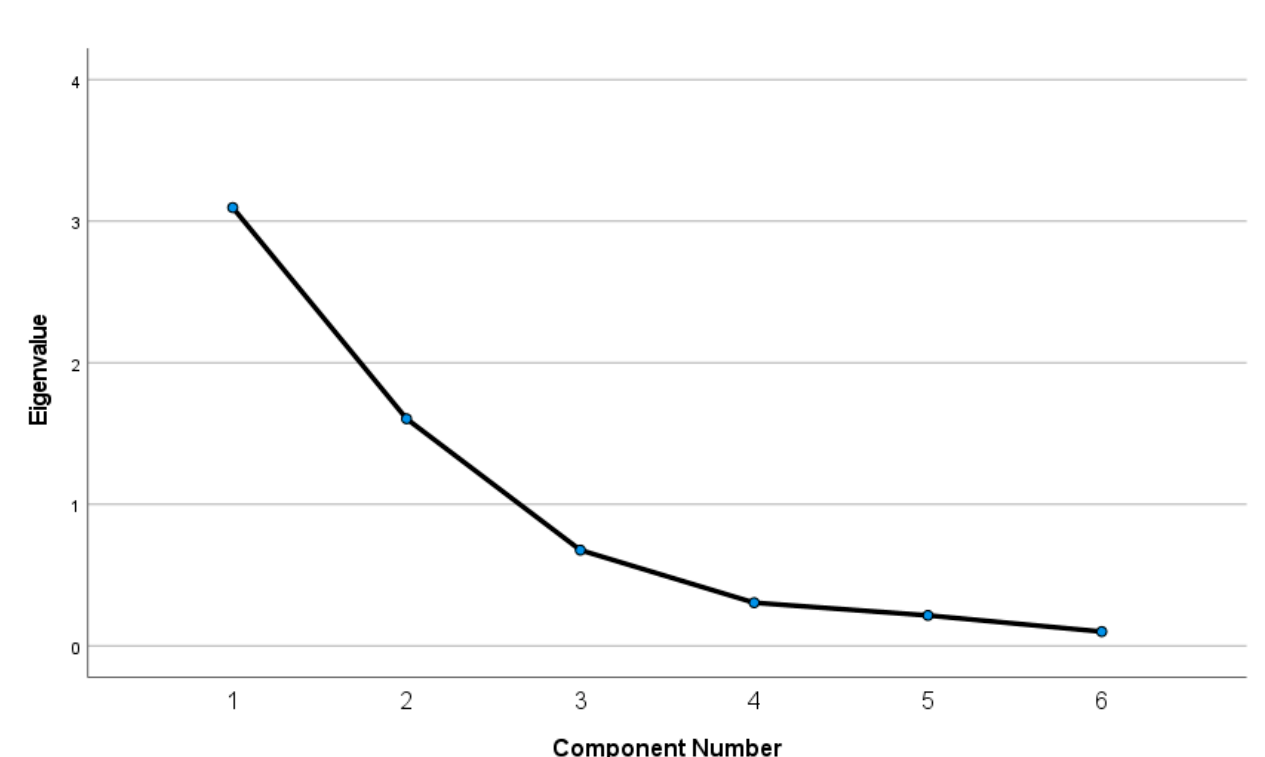
Table 17. Pattern matrix acquired in the principal component analysis regarding support for the decision-making process to implement Industry 4.0 solutions.